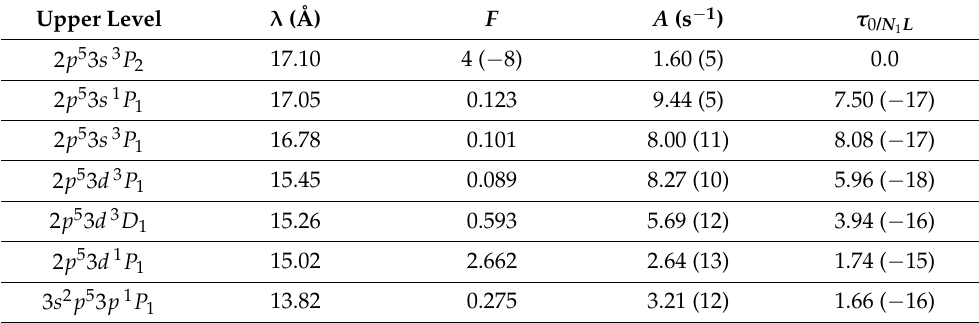
Table 9. Fe XVII resonance lines and forbidden line at 17.10 Å.